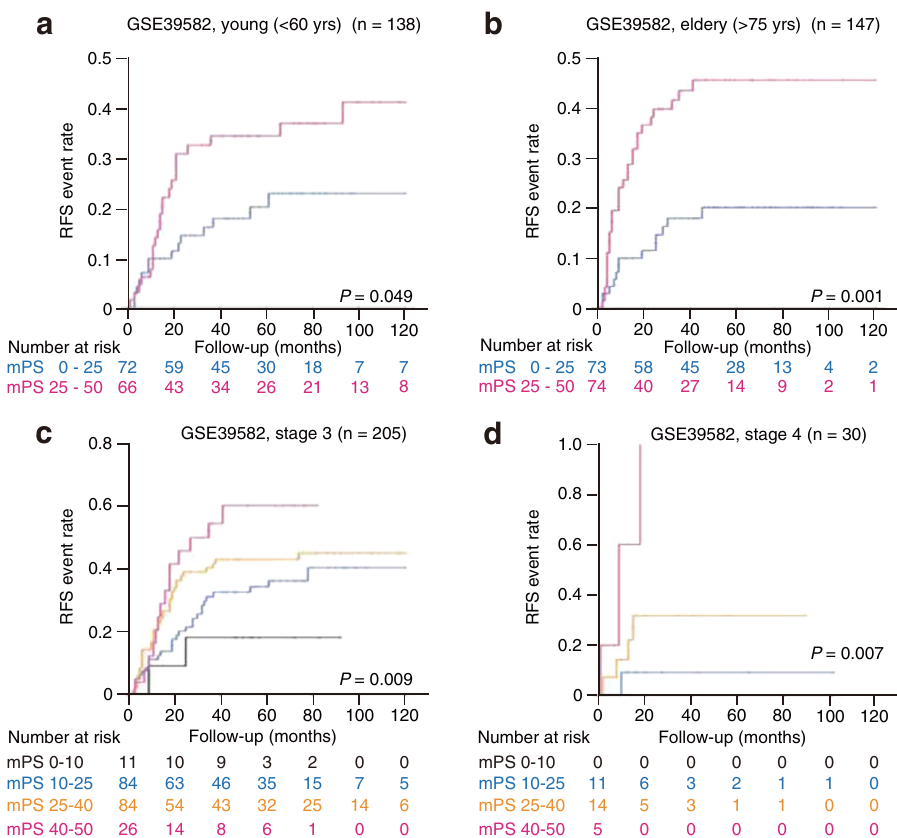
Fig. 3 mPS_colon strati fi es colorectal cancer patients regardless of age or disease stage. a , b Kaplan – Meier curves of relapse-free survival (RFS) for patients aged <60 years ( a ) or >75 years ( b ) in the GSE39582 cohort according to mPS_colon. The log-rank P values are shown. c , d Kaplan – Meier curves of RFS for patients with stage 3 ( c ) or stage 4 ( d ) disease in the GSE39582 cohort according to mPS_colon. The log-rank P values are shown. Only patients with available information are